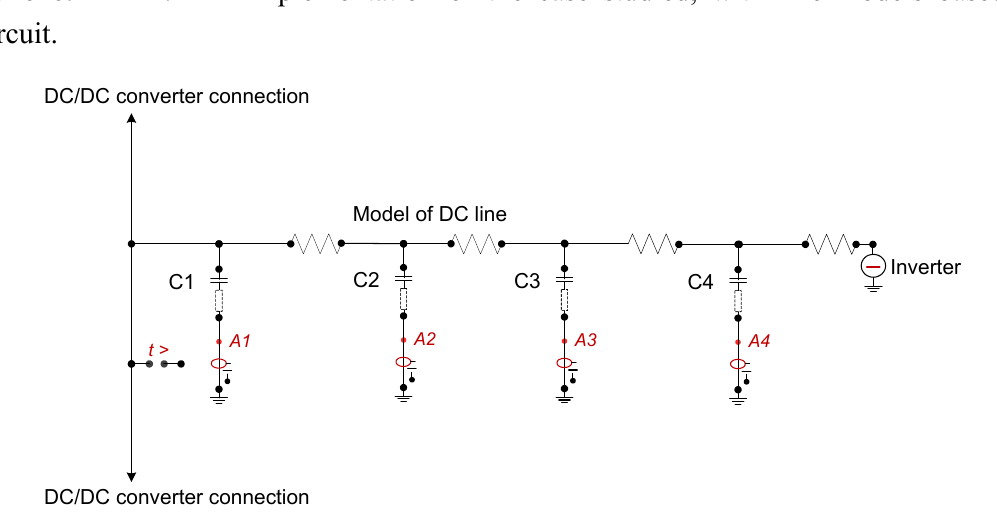
Figure 6. EMTP/ATP implementation of the case studied, with line models based on π circuit.